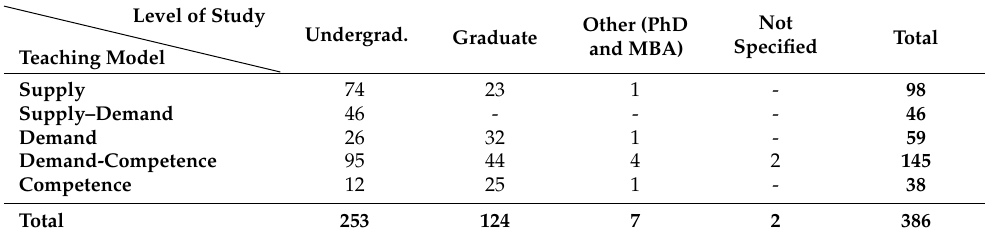
Table 5. Distribution of respondents according to teaching models and levels of study.